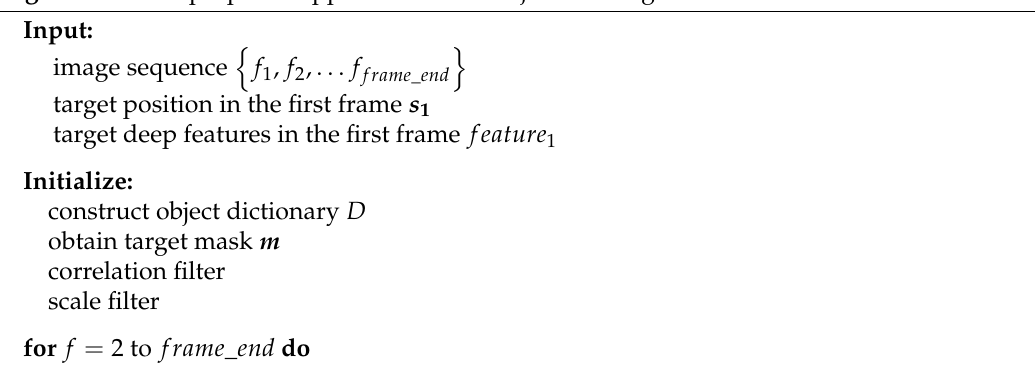
Algorithm 2 The proposed approach for TIR object